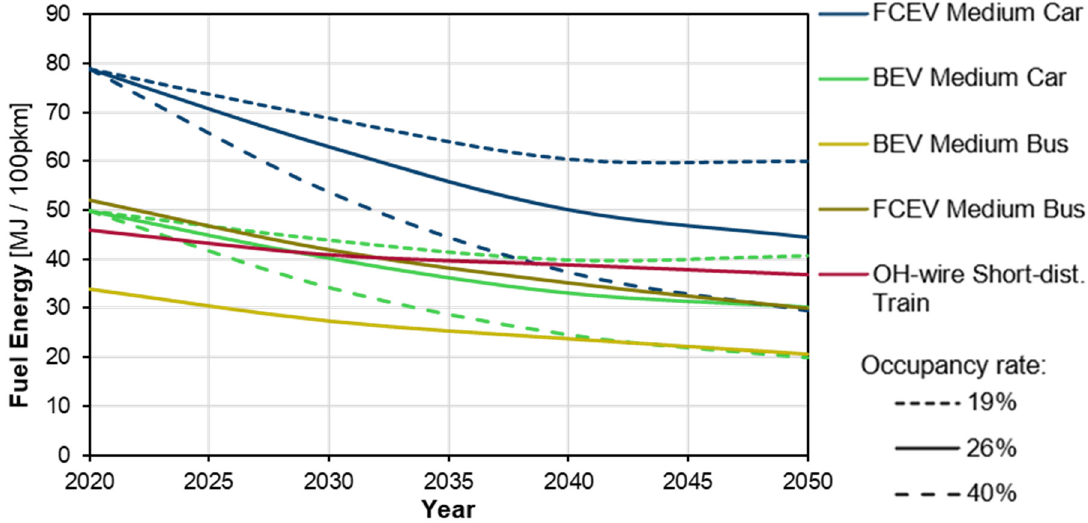
Figure 18. Change in energy demand for medium cars due to changes in occupancy rates in the future, brought about by autonomous vehicles. The figures for buses and trains are shown for com- parison. For the model’s default values, please see Table 3.